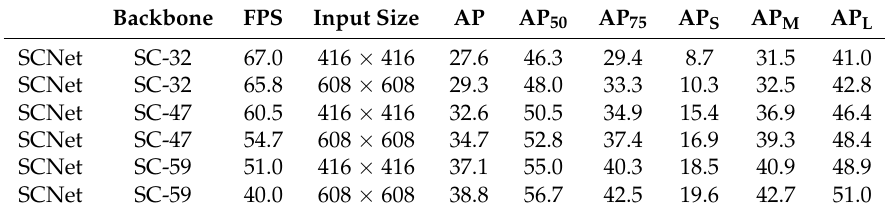
Table 2. Speed-accuracy trade off with different backbone networks, the results are tested on the COCO val